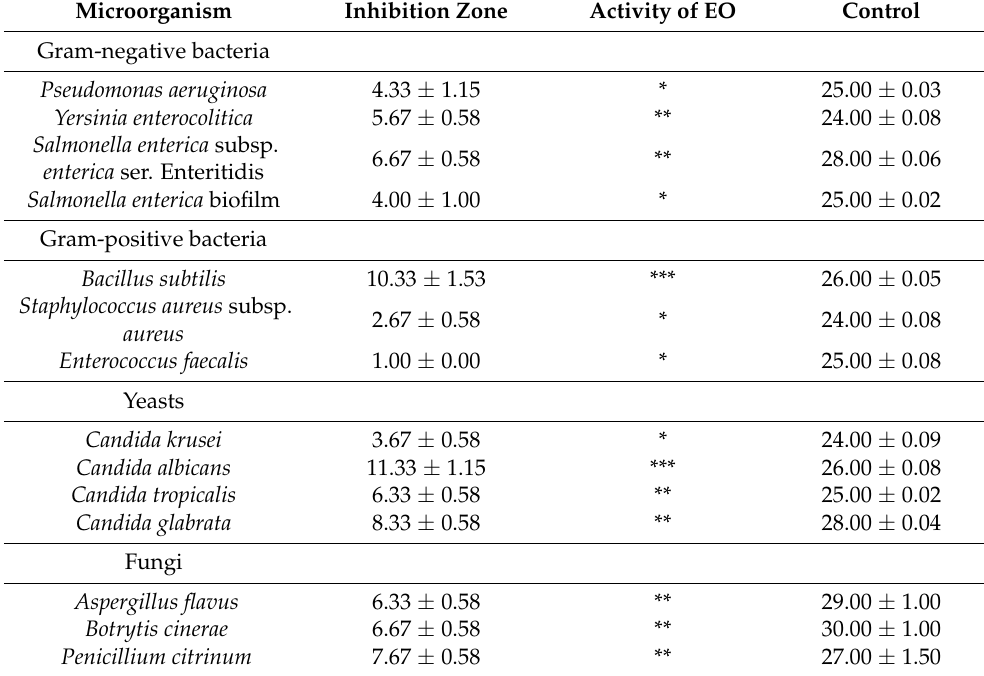
Table 3. Antimicrobial activity of CSEO with disc diffusion method.